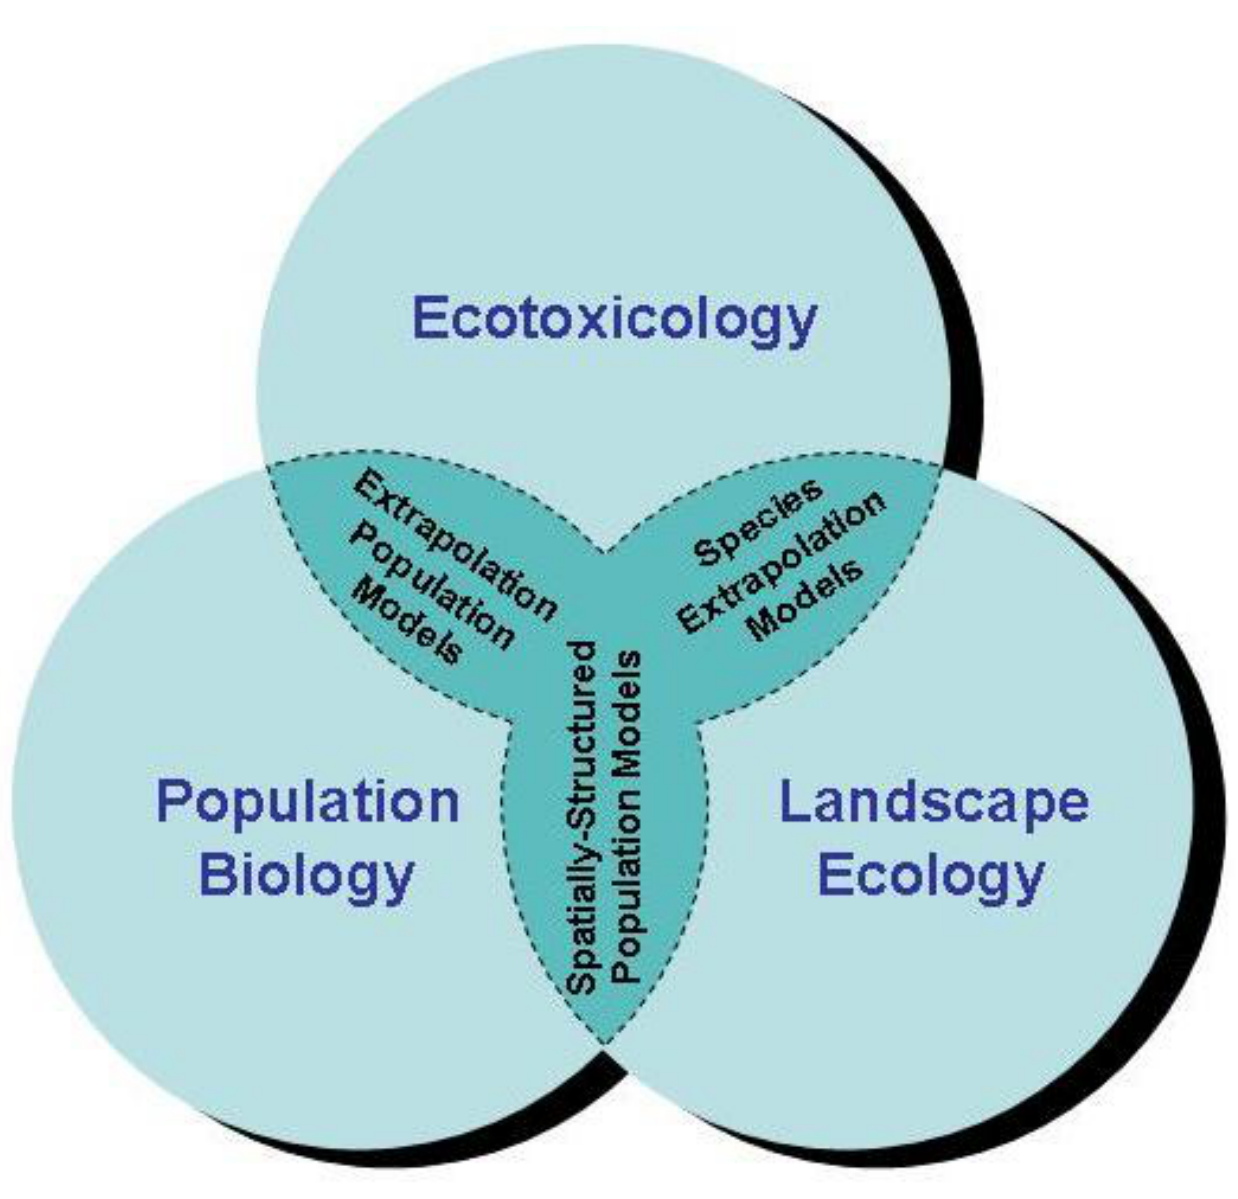
Fig. 1. The Wildlife Research Strategy at the intersection of the disciplines of ecotoxicology, population biology, and landscape